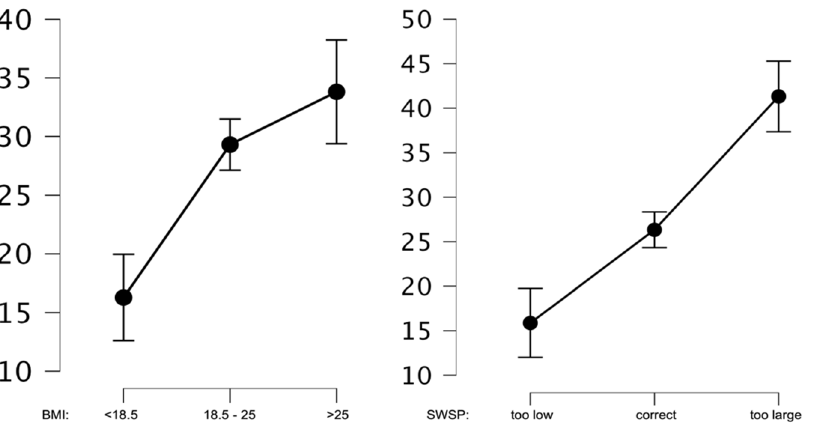
Figure 2. Average AGF values for BMI and SWSP.